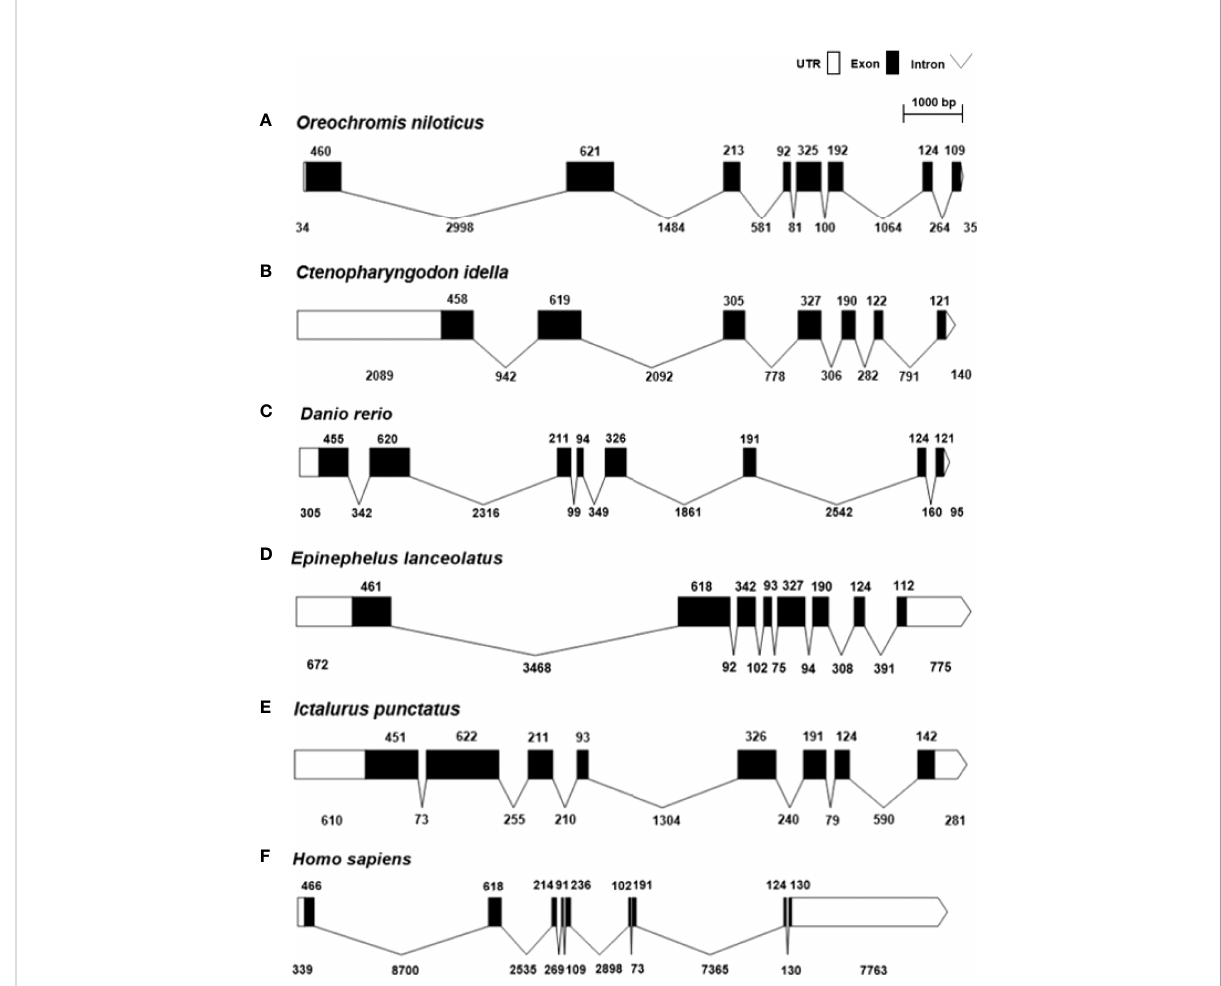
FIGURE 2 Genomic structure of SARM1 from (A) Oreochromis niloticus (XM_003458624), (B) Ctenopharyngodon idella (JX887876), (C) Danio rerio (NM_001130596), (D) Epinephelus lanceolatus (XM_033631735), (E) Ictalurus punctatus (XM_017491372), and (F) Homo sapiens (NM_015077). The white and black bars represent untranslated regions (UTRs) and exons, respectively, while introns are indicated by thin black